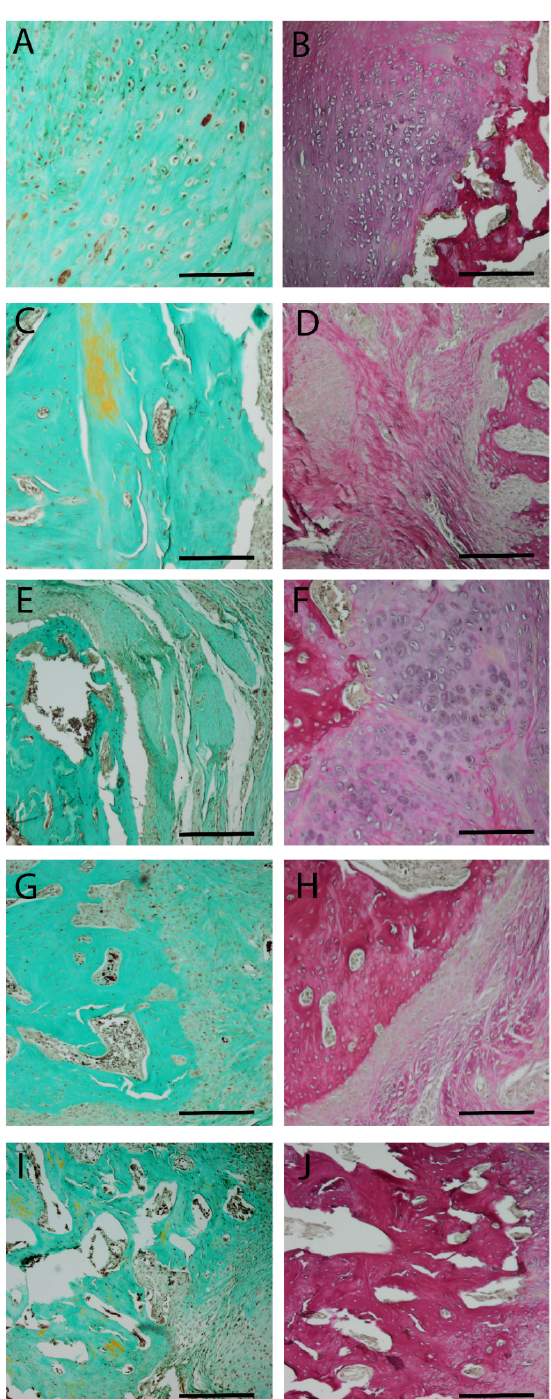
Figure 6. Masson–Goldner (first column) and Elastica van Gieson (second column) staining 8 weeks after surgery. Central parts of the fracture are shown. Group 1—no implant—( A , B ); 2—PLA cylinder alone—( C , D ); 3—PLA cylinder + collagen type I—( E , F ); 4—PLA cylinder + collagen type I + SDF-1—( G , H ); 5—PLA cylinder + collagen type I + BMP-7—( I , J ). Scale bars: 1000 µ